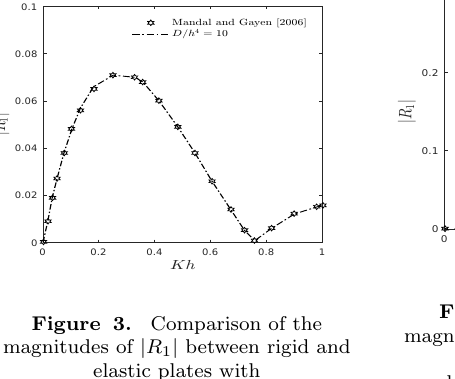
Figure 4. Comparison of the magnitudes of | R 1 | between the results for the sole effect of bottom undulation [15] and our results with negligible plate lenth for fixed M = 3 ,c 0 /h = 0 . 1 ,λh = 1 and l 1 /h = 0 .